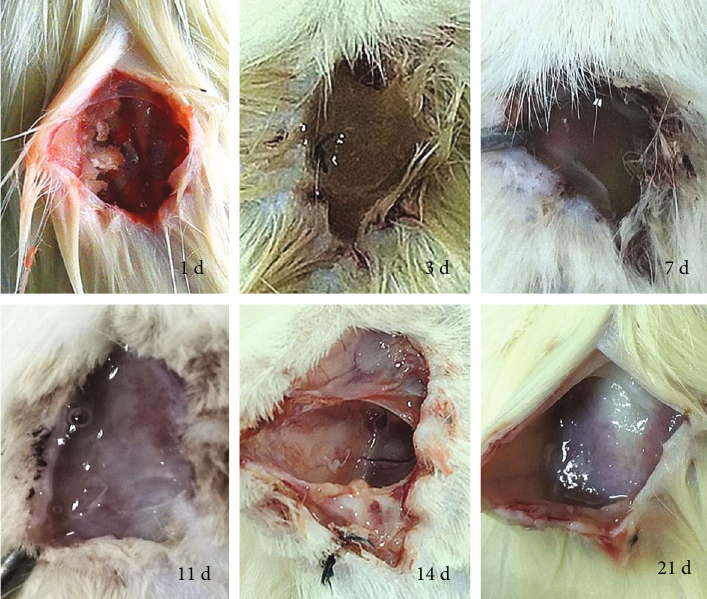
Figure 4: Morphological changes in the degradation of cellulose composite in rats. After